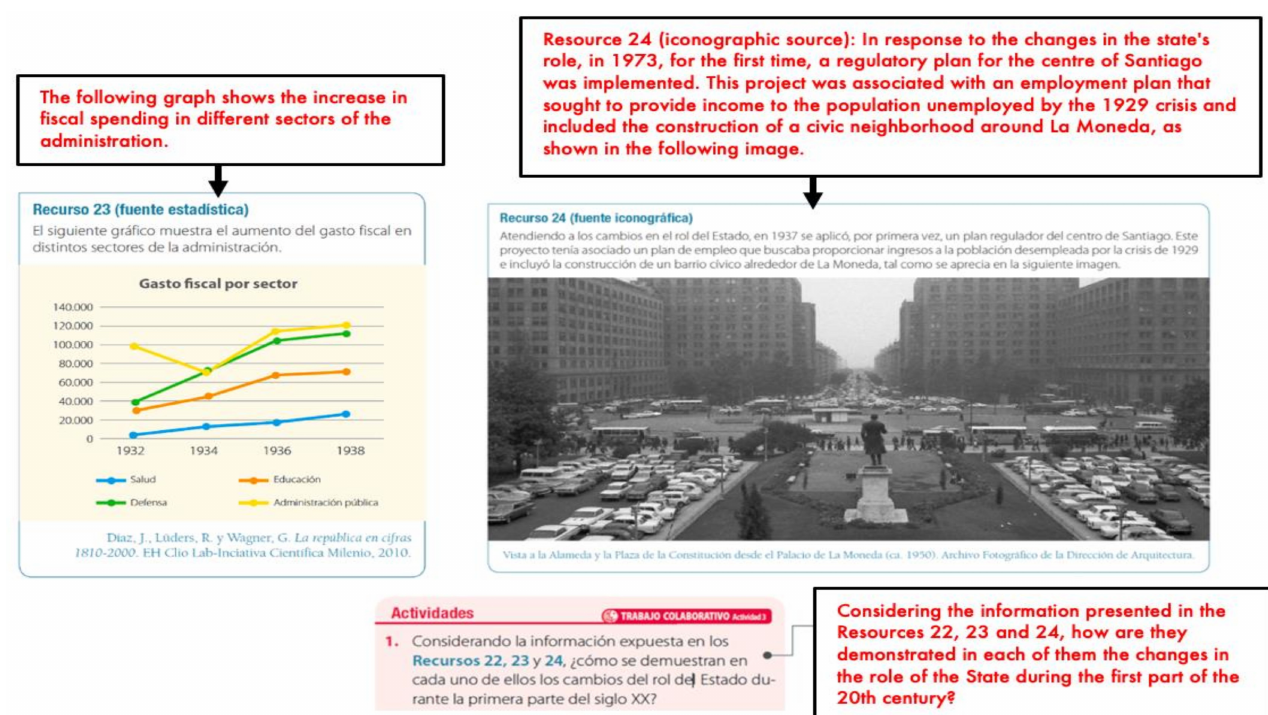
Figure 20. Presence of types of variable types (Adapted from [35] p.